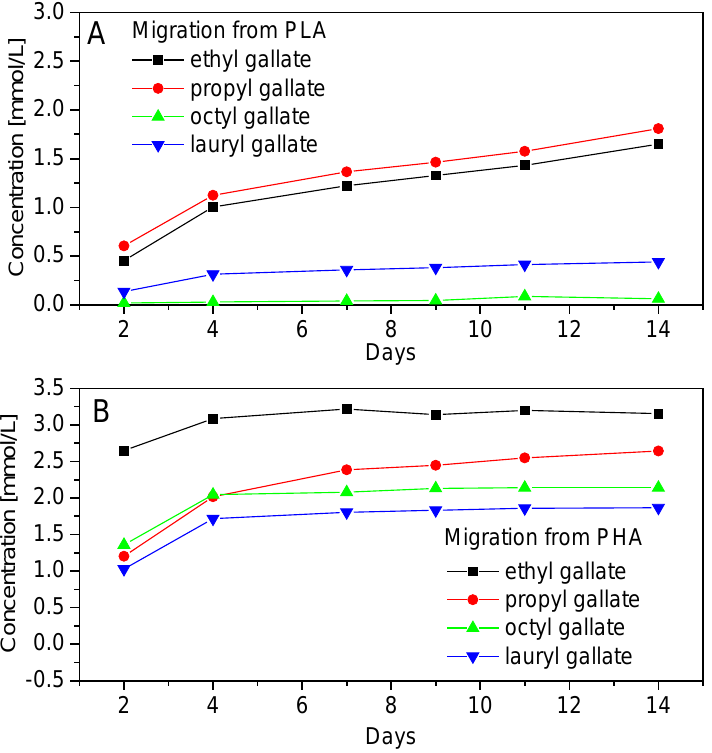
Figure 5. Migration of gallates from PLA ( A ) and PHA ( B ) during 14 days.